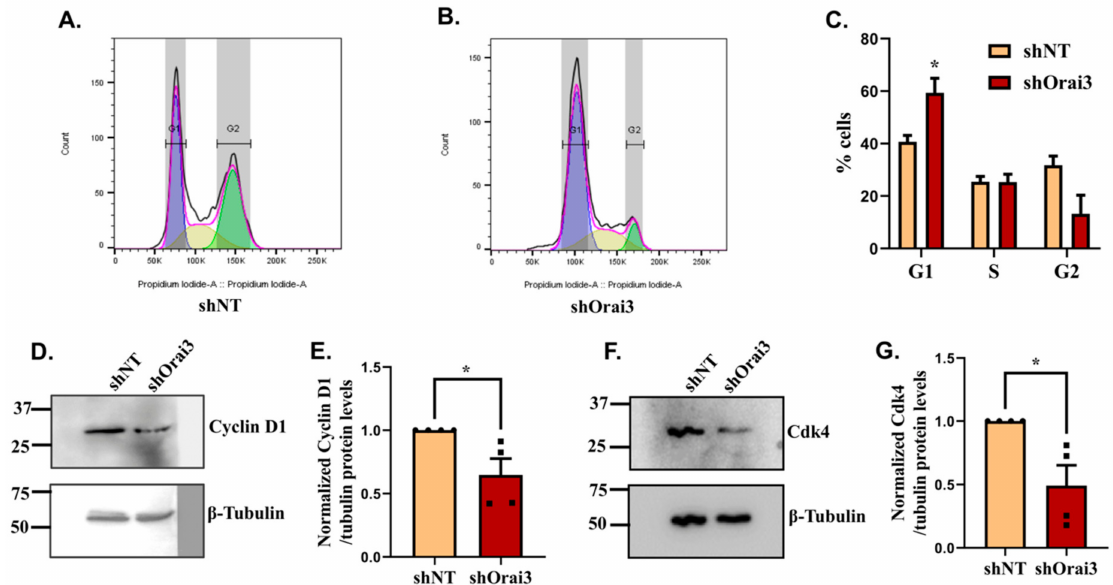
Figure 5. Orai3 contributes to Panc1 cell-cycle progression. ( A , B ) Representative data showing FACS-based cell-cycle analysis of Panc1 shNT and Panc1 shOrai3 stable cells. Cell-cycle analysis was performed with three independent biological experiments using propidium iodide. ( C ) Quantitative analysis of % cells in different phases of cell cycle in the case of Panc1 shNT and Panc1 shOrai3 stable cells ( n = 4). ( D ) Western blot analysis for cyclin D1 expression in shNT and shOrai3 Panc1 stable cell lines. ( E ) Densitometric analysis of cyclin D1 levels in shNT and shOrai3 Panc1 stable cells. ( F ) Western blot analysis for Cdk4 expression in shNT and shOrai3 Panc1 stable cell lines. ( G ) Densitometric analysis of Cdk4 levels in shNT and shOrai3 Panc1 stable cells. Data presented as mean ± S.E.M. Unpaired Student’s t -test was performed for statistical analysis. p -value < 0.05 was considered as significant and is presented as